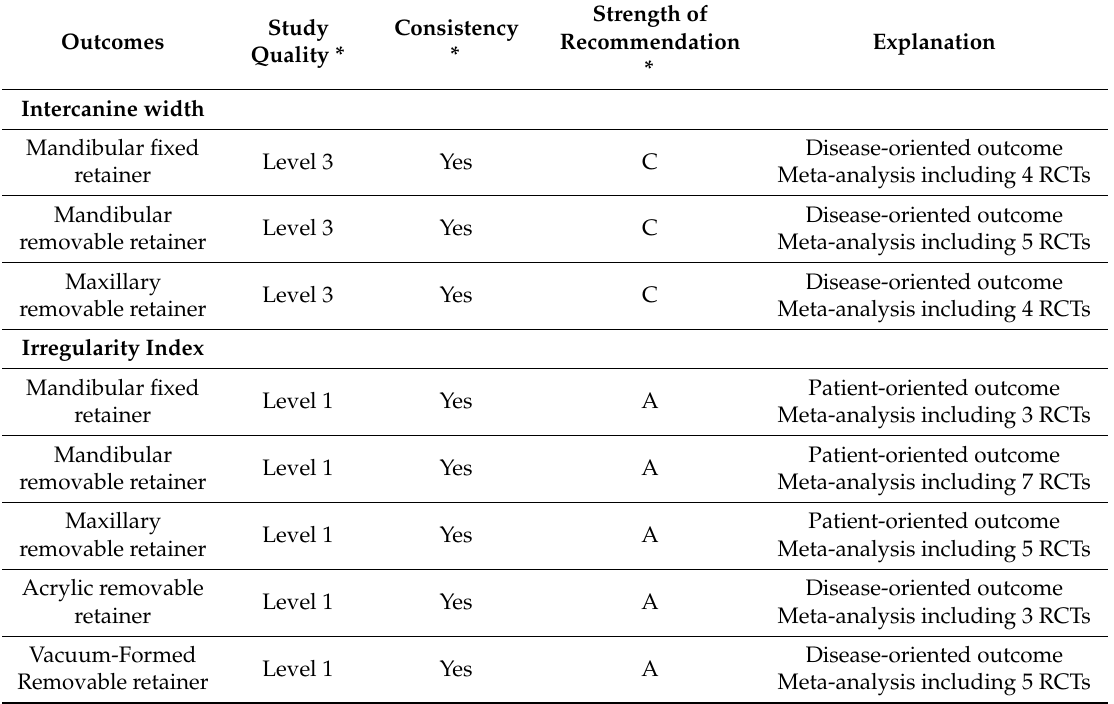
Table 7. Strength of recommendations for each outcome investigated in the present